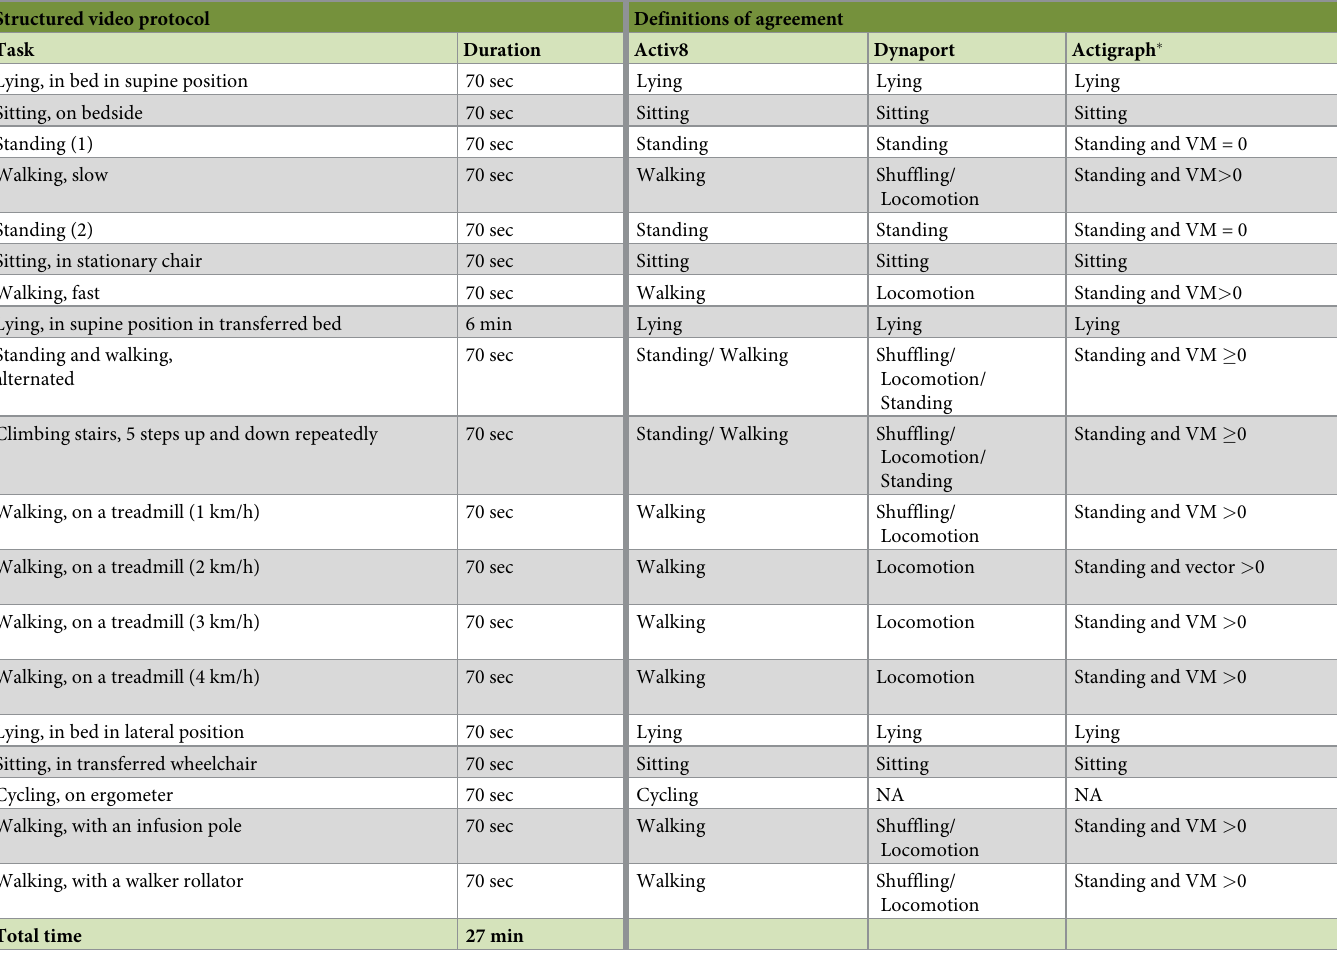
Table 1. Structured video protocol and definitions of agreement per accelerometer. Structured video